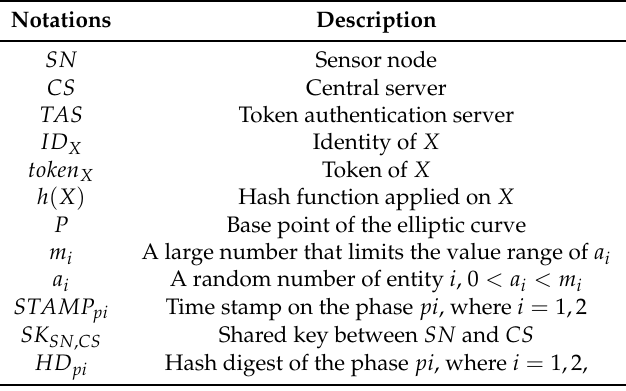
Table 1. Symbols and notations used in the